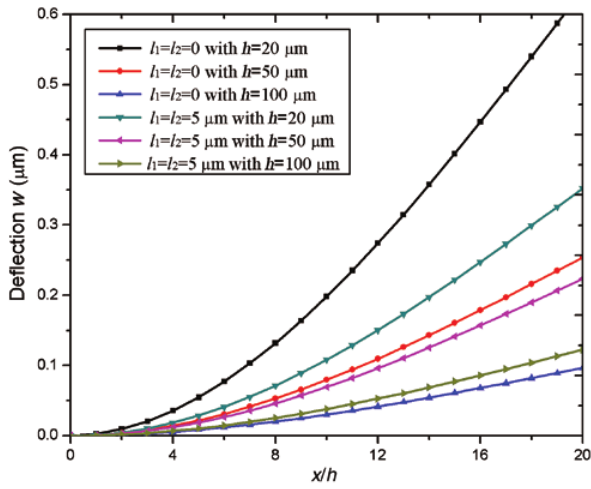
Figure 4: Variation of the deflection of piezoelectric beam along the beam with different